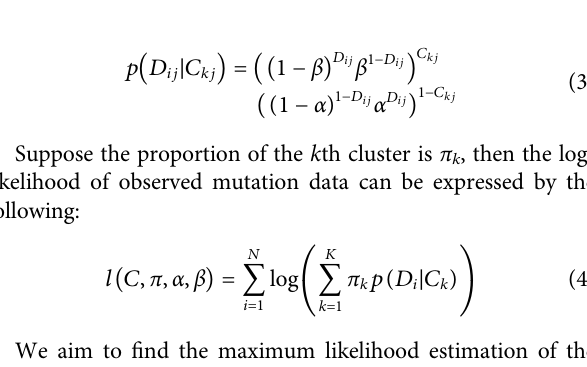
Figure 1 . SCClone employs an EM-based clustering model to decipher the clonal composition of the tumor and the error rates.